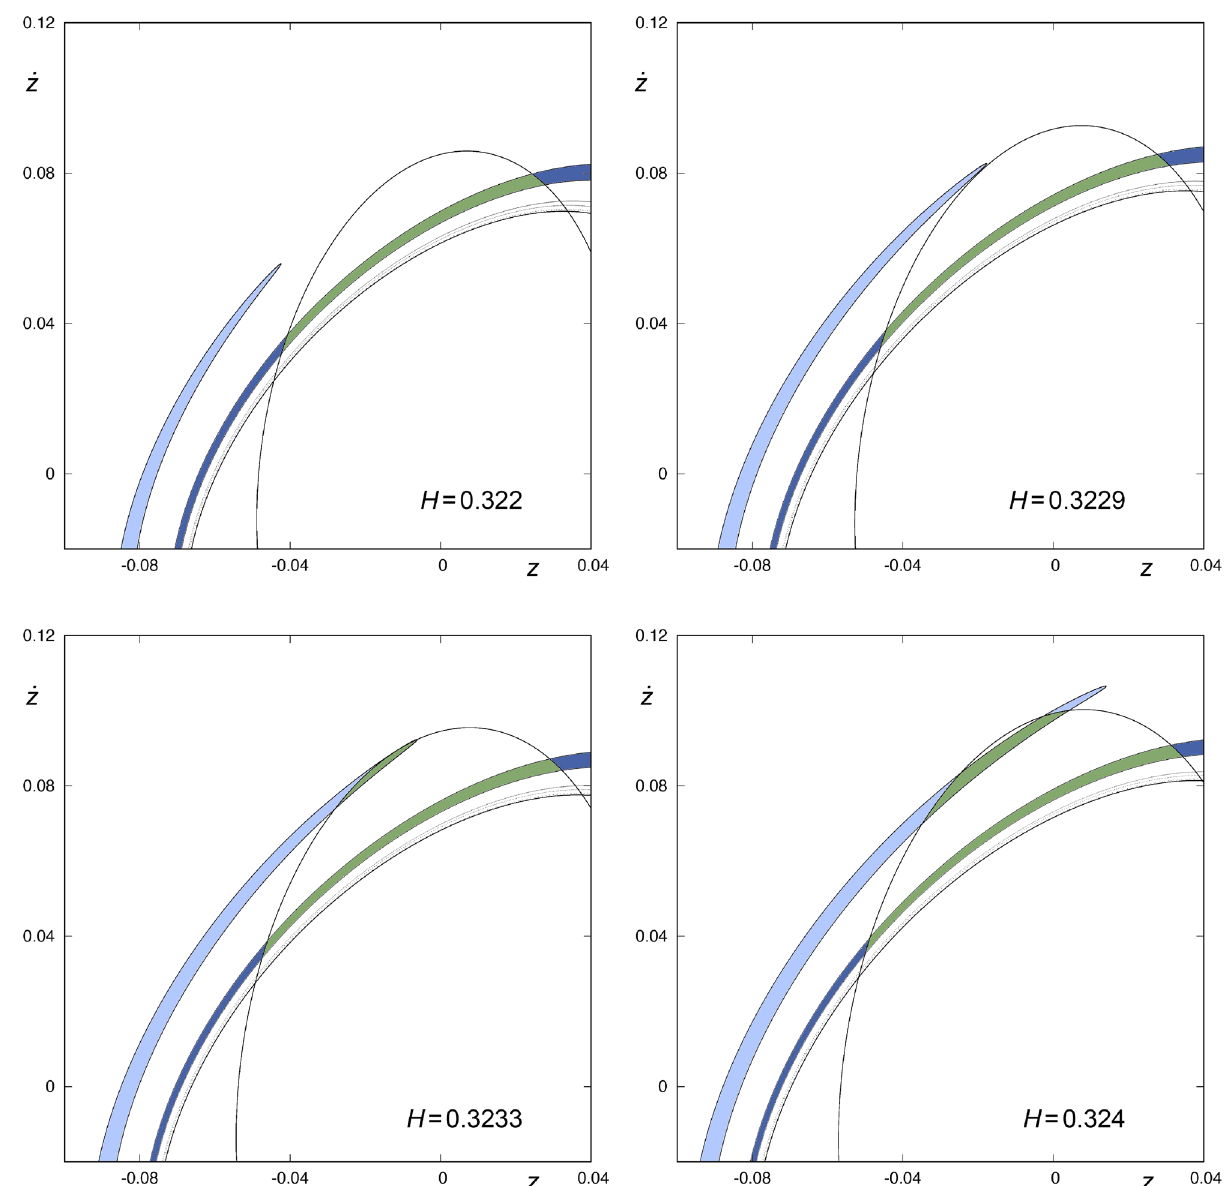
Figure 6. Detail of W s ,4 (φ) and W u ,1 (φ) for H = 0.322, 0.3229, 0.3233 and 0.324. The area enclosed by W s ,4 (φ) is colored in green or blue, depending on whether it is contained in the area enclosed by not, respectively. Orbits starting in the green colored area enter the central part of the galaxy from the infinity and, after intersecting the surface of section r = ¯ r at four points, leave the potential well. This graphic has been generated by using Gnuplot Version 5.2. http:// www. gnupl ot.